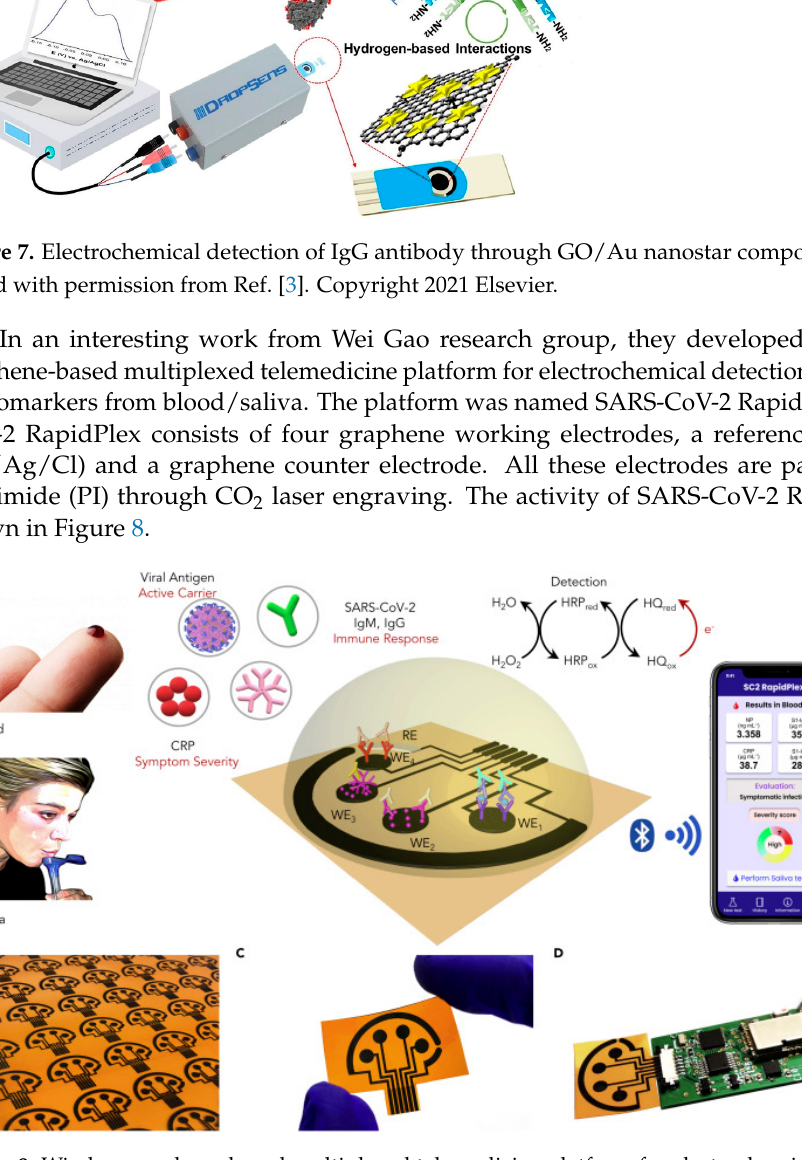
Figure 8. Wireless graphene-based multiplexed telemedicine platform for electrochemical detection of COVID-19 biomarkers from blood/saliva ( A ) Schematic illustration of the SARS-CoV-2 RapidPlex multisensor telemedicine platform for detection of SARS-CoV-2 viral proteins, anti-bodies (IgG and IgM), and inflammatory biomarker C-reactive protein (CRP). Data can be wire-lessly transmitted to a mobile user interface. WE, working electrode; CE, counter electrode; RE, reference electrode ( B ) Mass-producible laser-engraved graphene sensor arrays ( C ) Photograph of a disposable and flexible graphene array ( D ) Image of a SARS-CoV-2 RapidPlex system with a graphene sensor array connected to a printed circuit board for signal processing and wireless communication. Reproduced with permission from Ref. [15]. Copyright 2020 Cell Press, Else-vier.